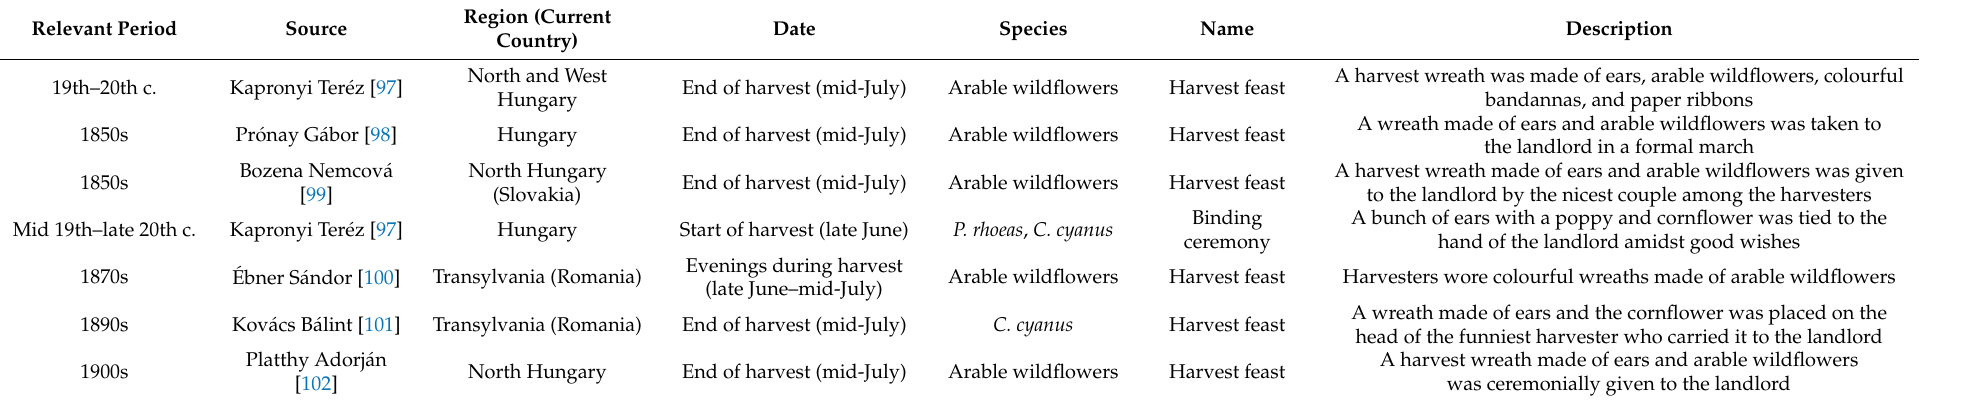
Table 2. Records on the uses of arable wildflowers in harvest festivals from the 19th century in the Carpathian